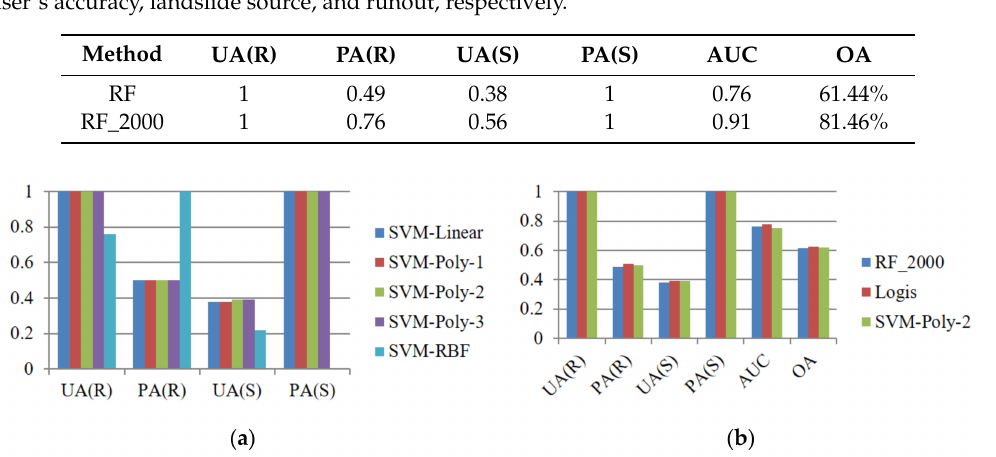
Figure 12. Performances (Y- axis) of the No. 5 model, where OA, AUC, PA, UA, S, and R represent the overall accuracy, area under ROC curve, producer’s accuracy, user’s accuracy, landslide source, and runout-out, respectively. ( a ) Using SVM with linear, the first- to third-order polynomial, and radial basis (RBF) functions, ( b ) comparing the optimal best results of Table 5 and ( a ) with logistic (Logis) regression.